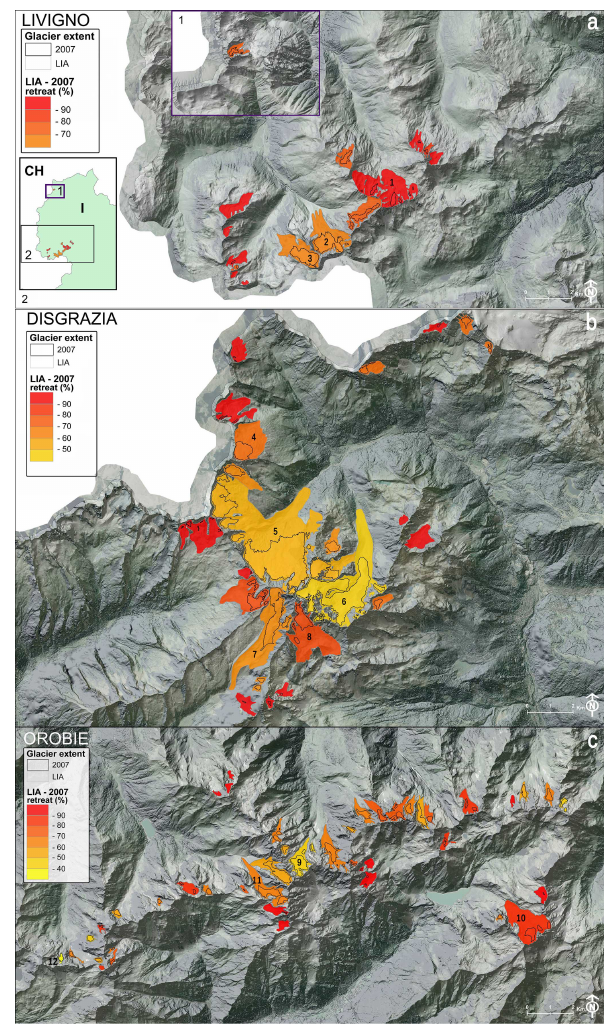
Figure 6. Maps showing the glacier extents in 1860 (LIA) and 2007, and the spatial distribution of the relative change in glacier area in (a) Livigno, (b) Disgrazia, and (c) Orobie. Numbers refer to the glaciers cited in the text. 1: Mine, 2: Campo Nord, 3: Val Nera Ovest, 4: Vazzeda, 5: Disgrazia/Sissone, 6: Ventina, 7: Predarossa, 8: Cassandra, 9: Lupo, 10: Trobio, 11: Scais, 12: Aga. The northern- facing Disgrazia–Sissone and Ventina glaciers display a smaller rel- ative retreat (56 and 45%, respectively) compared to the southern- facing counterparts of Predarossa (69%) and Cassandra (83%) that are similar in size and that flow down from the same summits (see also Fig. 11b).